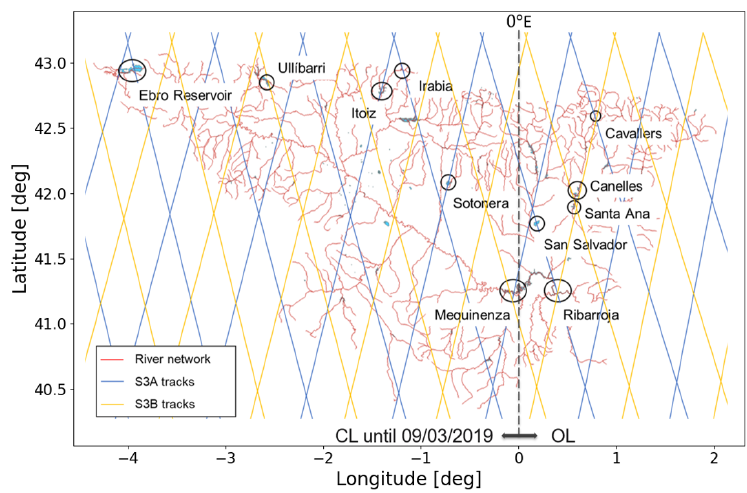
Figure 49. Map of Ebro basin showing key rivers and